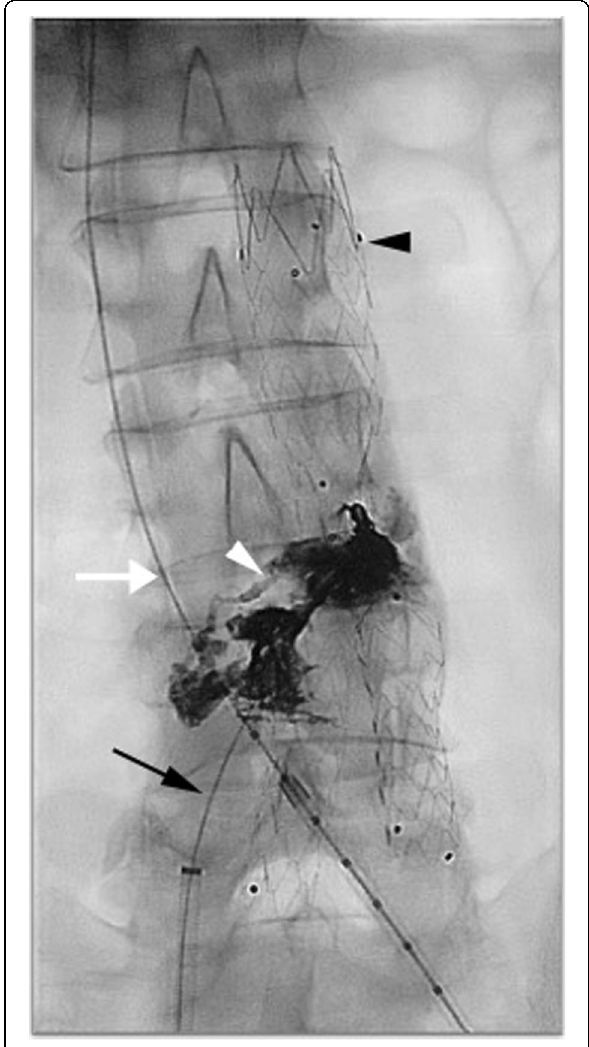
Fig. 3 Fluoroscopic image obtained during the embolization procedure showing ethylene vinyl alcohol liquid embolic (Onyx®) administration via the microcatheter (black arrow). Guidewire and intravascular ultrasound (IVUS) probe (white arrow) within the IVC inserted through the left common iliac vein. Aortic stent graft (black arrowhead). Onyx® within the excluded aneurysm sac (white arrowhead)